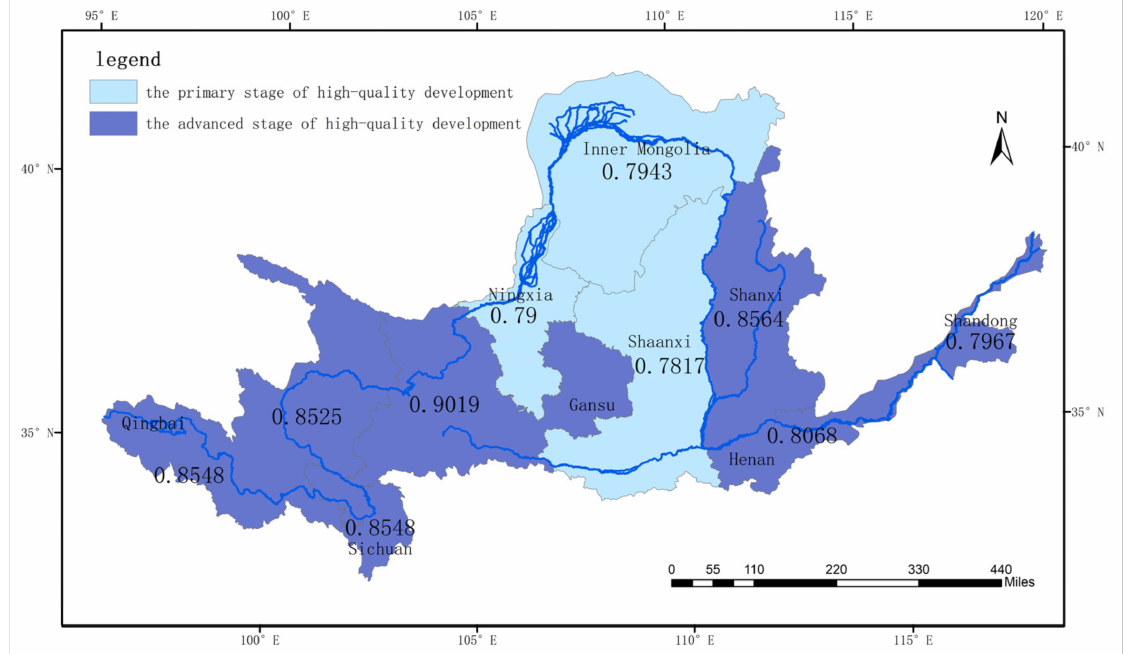
Figure 10. Yellow River basin high-quality development evaluation